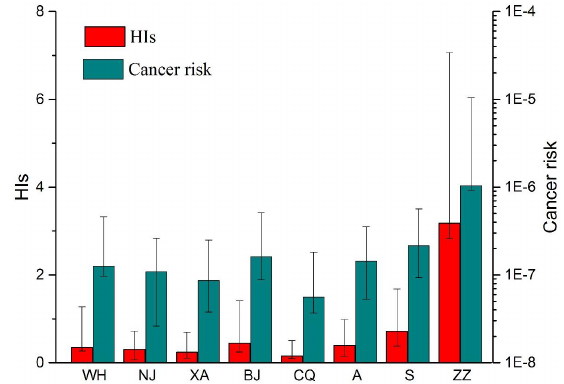
Figure 2. A comparison of HIs and cancer risk of arsenic to children in street dust of Wuhu (WH), Nanjing (NJ), Xi’an (XA), Baoji (BJ), Chongqing (CQ), Avilés (A), Singapore (S) and this study (ZZ).